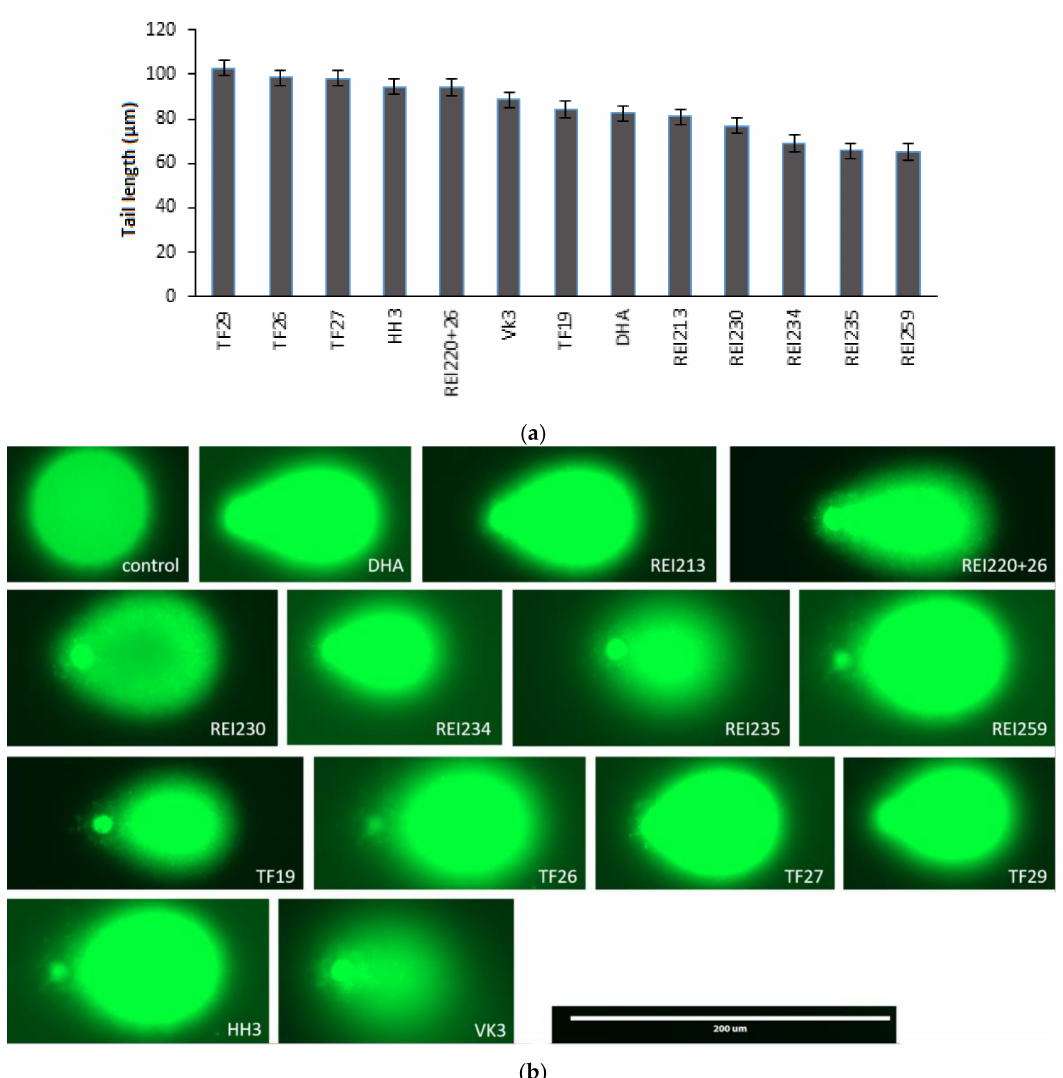
Figure 3. DNA damage induced by artemisinin-, egonol-, and thymoquinone-based hybrids. CCRF-CEM cells were each treated with10 µ M of the above compounds and harvested for 24 h. The cells were subjected to alkaline single-cell gel electrophoresis as described. ( a ) Quantified tail lengths are the mean values of at least three independent experiments ± SD; ( b ) Representative images of cells treated with ARTA